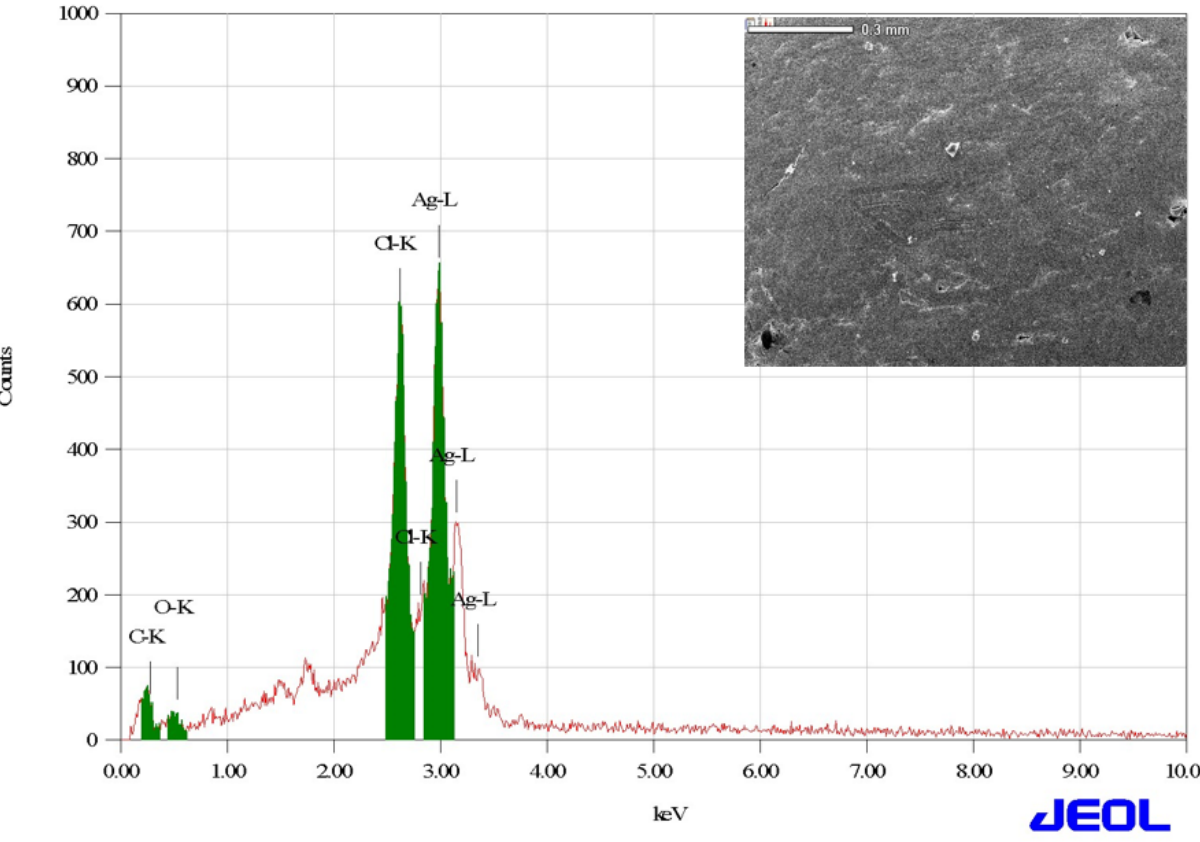
Figure 5. EDX spectrum and SEM graph of AgNPs fabricated using O. majorana extract.